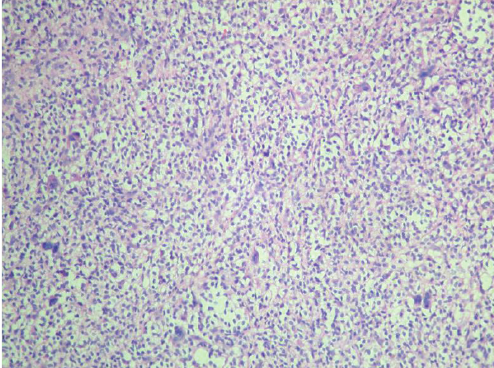
Figure 4: HE × 20 histiocytic and mononuclear cells, multinuclear giant